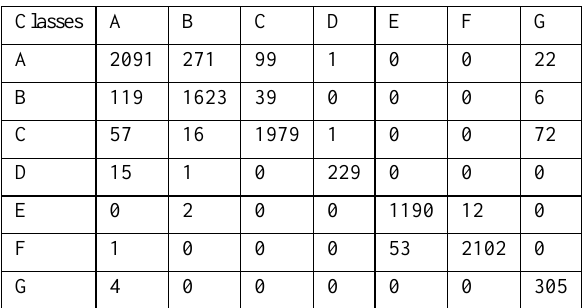
Table 3: Accuracy assessment for ANN, SVM, ML and SAM Table 4: Confusion matrix of ANN